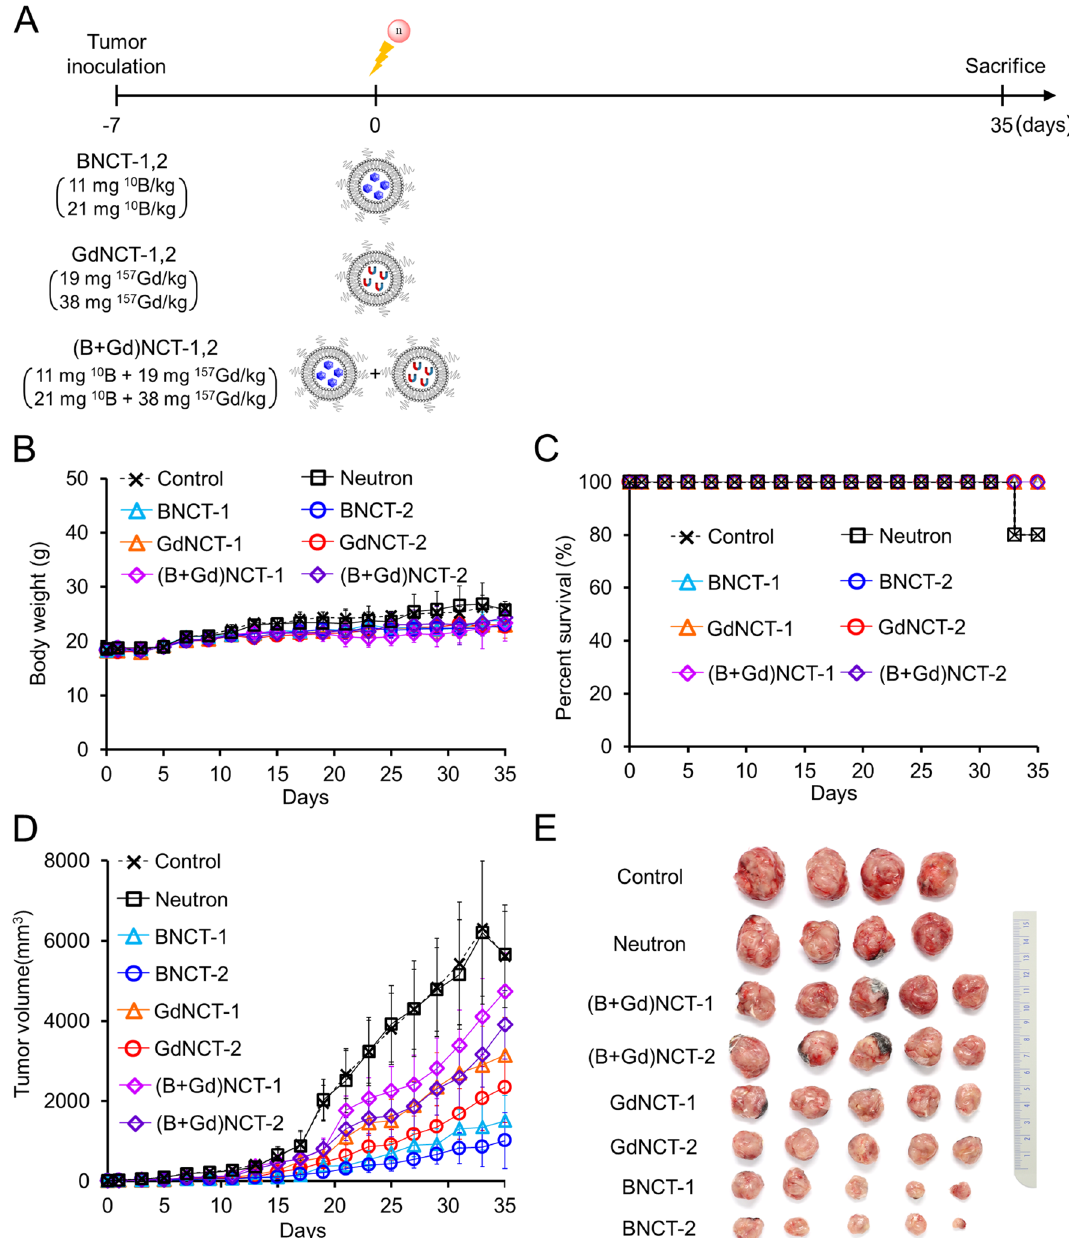
weights of each group after neutron irradiation. ( C ) Survival curve of each group up to 35 days after neutron irradiation. ( D ) Tumor growth curves of each group after neutron irradiation. ( E ) Photographs of tumors resected 35 days after neutron